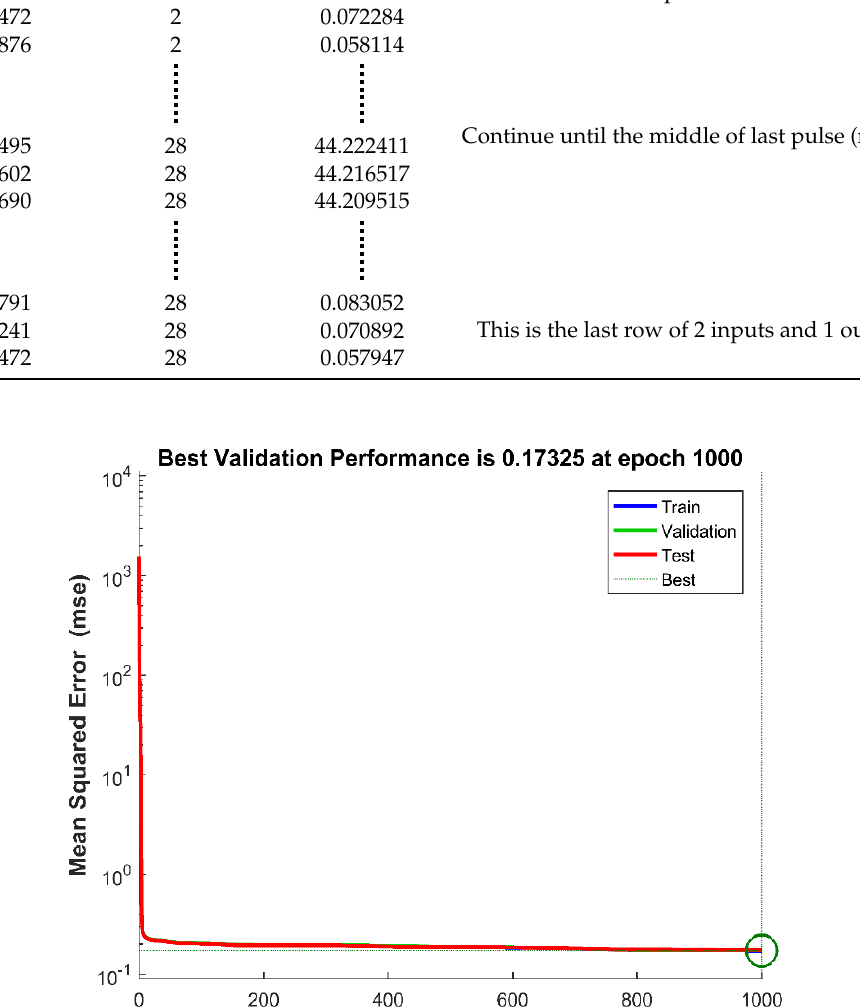
Figure 6. The performance of training, validation and test errors with training epochs. 3.3. Performance of the LMBP-ANN Model The performance of the LMBP-ANN model mainly depended on its ability to predict the experimental output data with reasonable accuracy. As shown in Figure 7, the ANN model output was able to accurately predict the self-calibration of the pressure relative to the actual experimental data. For instance, the coefficient of determination (R 2 ) of model prediction versus experimental data for the training, validation and test data sets are 0.99975, 0.99975, and 0.99974, respectively. Thus, it can be argued that the proposed ANN model captured the relationships between the provided input